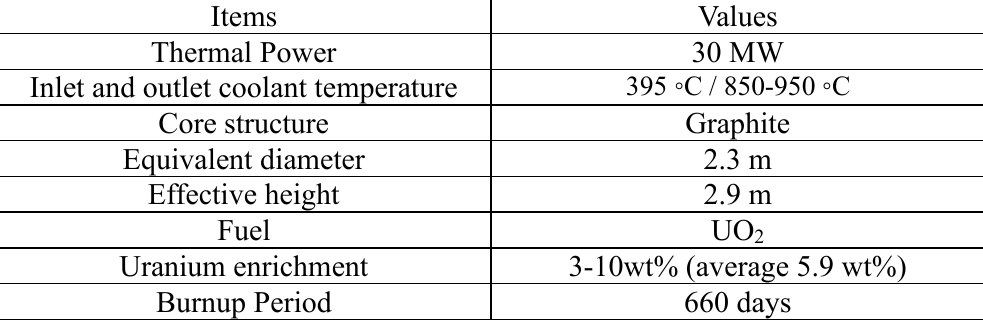
Table I. Major specification of HTTR